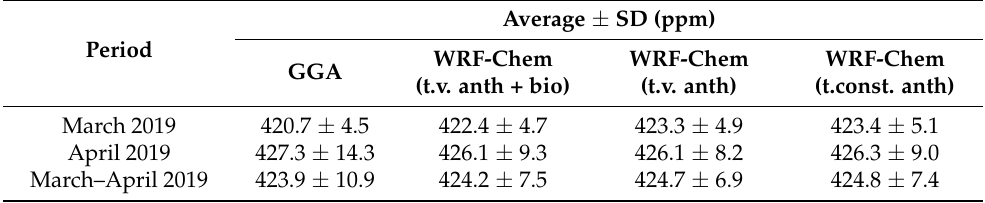
Table 6. Statistical characteristics of the observation and WRF-Chem data for Peterhof in March and April 2019. Here, t.v. is temporal variation; t.const. is time constant.